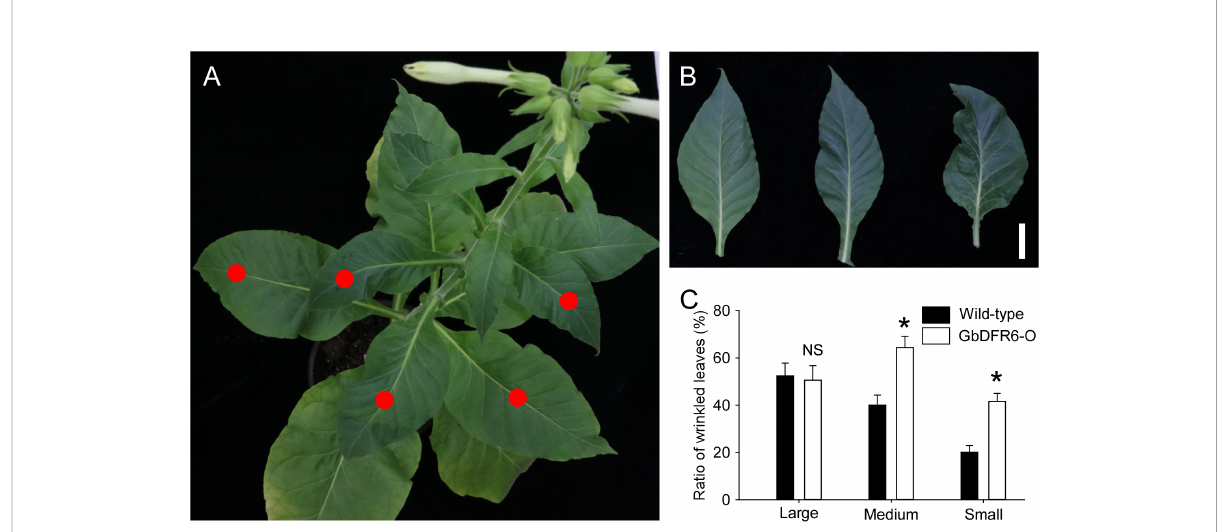
FIGURE 3 Leaf wrinkling in tobacco plants. (A) A typical fl owering stage of the wild-type tobacco plant with wrinkled leaves indicated by red dots. (B) Varying degrees of tobacco leaf wrinkling. Left, an unfolded leaf; middle, an intermediate wrinkled leaf; right, a severely wrinkled leaf. Bar = 1 cm. (C) Comparisons of wrinkled leaf ratios between wild-type and transgenic tobacco plants with small (width < 2 cm), medium (width of 2 – 7 cm), and large (width > 7 cm) leaves. Data for independent experiments are shown (means ± SD; n = 20; * indicates signi fi cant differences, P < 0.01; NS, not signi fi cant, P > 0.05; Student ’ s t